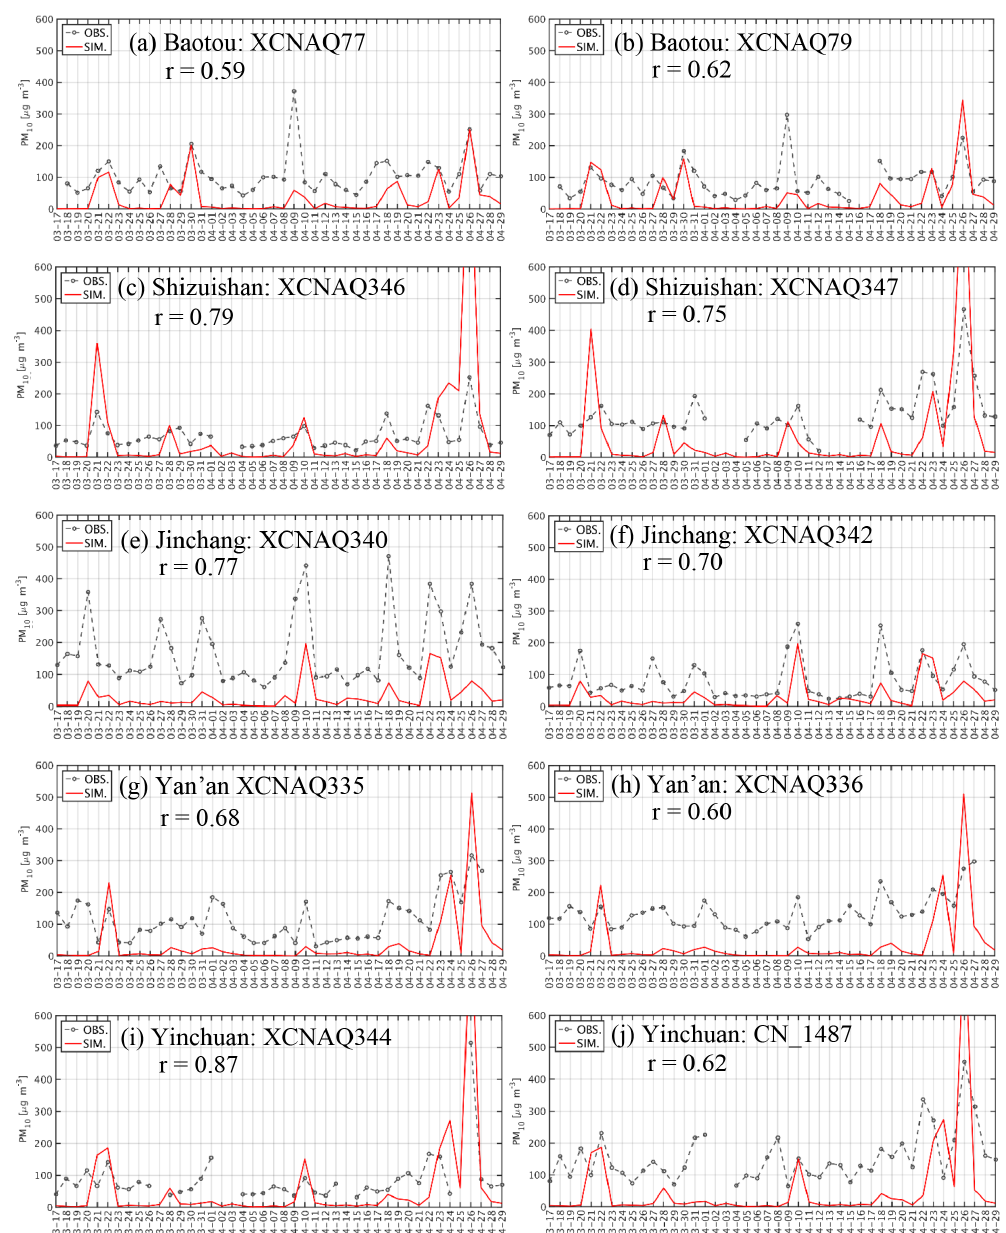
Figure 3. Time series of hourly observed and simulated surface PM 10 concentrations at various environmental monitoring stations; r repre- sents the correlation coefficient between simulation results and